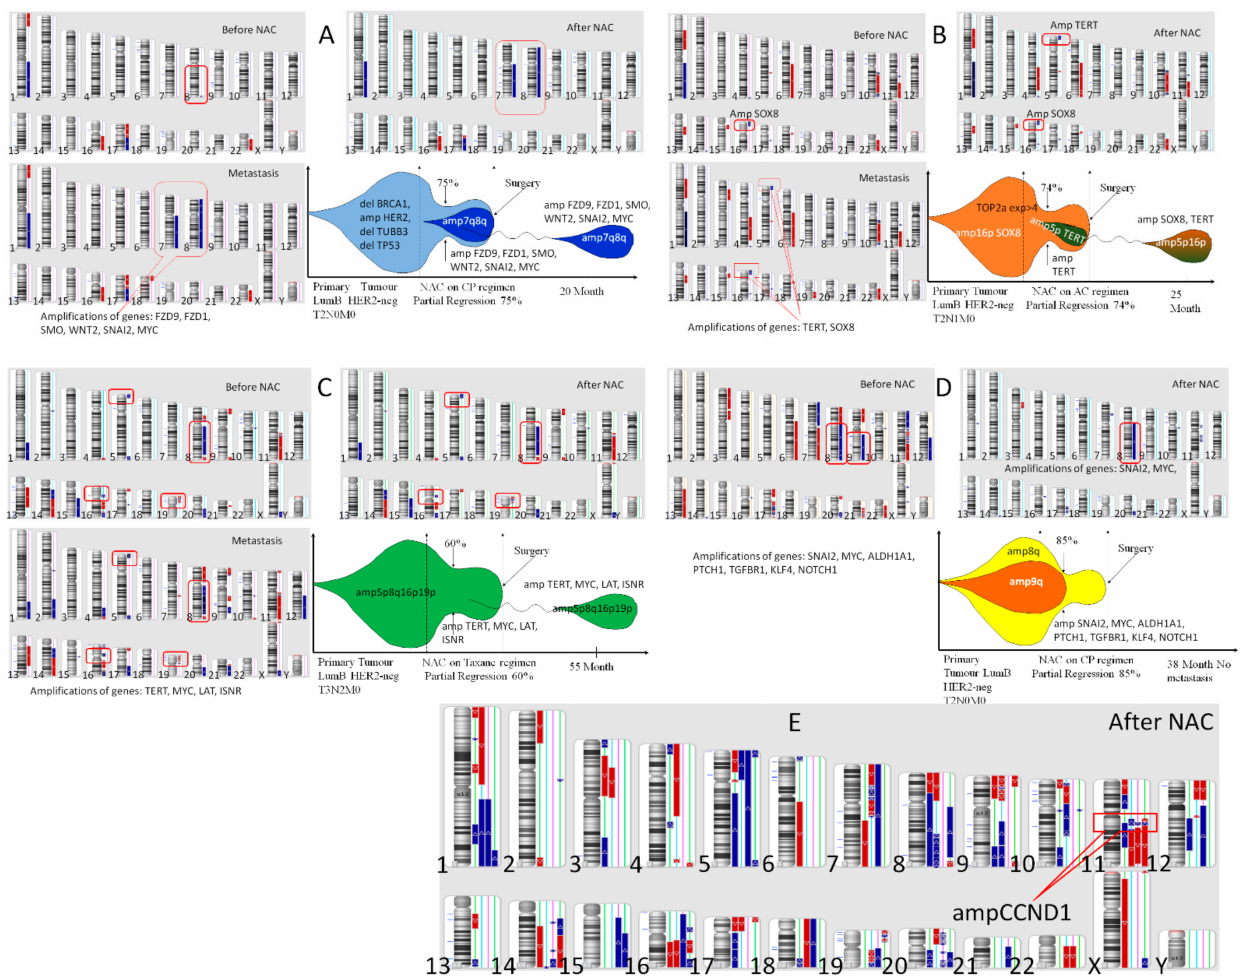
Figure 3. CNA genetic landscape of the tumor before treatment and after NAC, and metastasis. ( A ) The K1 patient of Group 3, 47 years of age, with luminal B left breast cancer T 2 N 0 M 0 , underwent four courses of CP treatment with 75% partial regression, surgery without complications, hormonal therapy after surgery; a metastatic tumor was found in the liver 20 months later. ( B ) The B2 patient of Group 3, 50 years of age, with luminal B right breast cancer T 2 N 1 M 0 , underwent six courses of AC treatment with 74% partial regression, surgery without complications, hormonal therapy and radiotherapy after surgery; a metastatic tumor was found in the lung 25 months later. ( C ) The Ch1 patient of Group 1, 32 years of age, with luminal B right breast cancer T 3 N 2 M 0 , underwent six courses of taxane treatment with 60% partial regression, surgery without complications, hormonal therapy and radiotherapy after surgery; a metastatic tumor was found in the liver 55 months later. ( D ) The S2 patient of Group 1, 45 years of age, with luminal B right breast cancer T 2 N 0 M 0 , underwent six courses of CP treatment with 85% partial regression, surgery without complications, hormonal therapy after surgery; a metastatic tumor was not found 38 months later. ( E ) The CNA genetic landscape of the tumor after NAC of four patients of Group 1 with